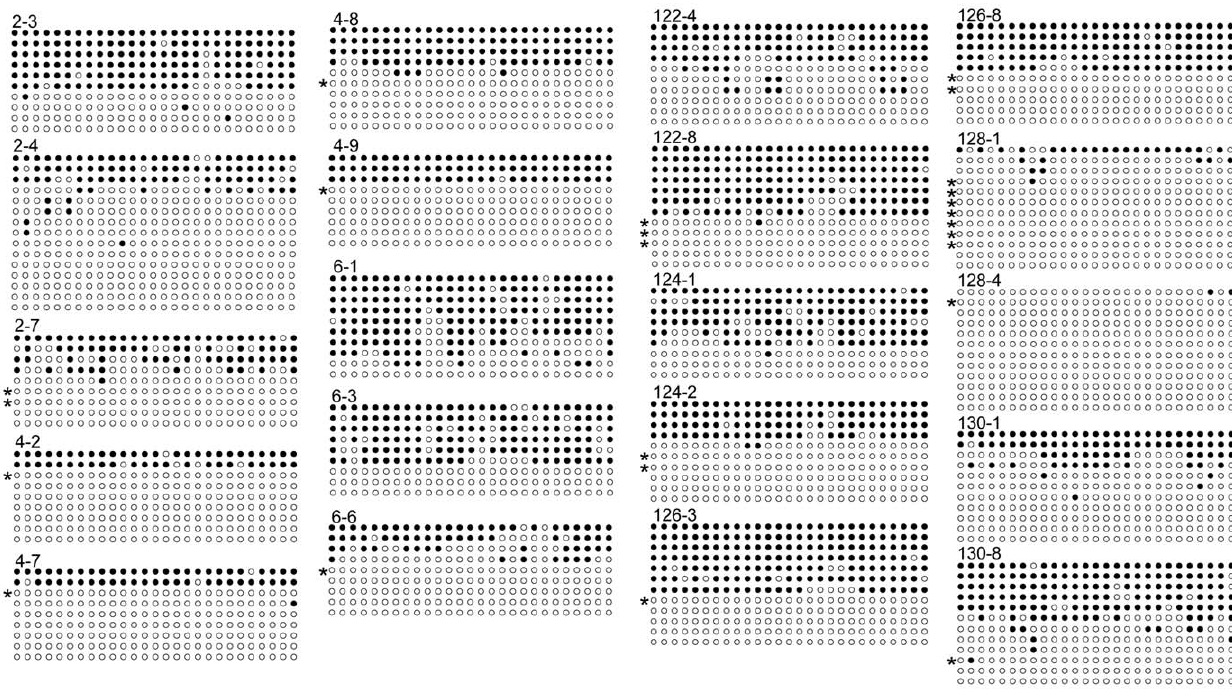
Figure 3. Bisulfite-sequencing of the 27 CpG sites in the rDNA spacer promoter region. A total of 20 E8 embryos, identified by hyphened numbers, were examined (filled circle: methylation). *Denotes the T haplotype identified by the 2 2214 G/T SNP in Figure 1A.